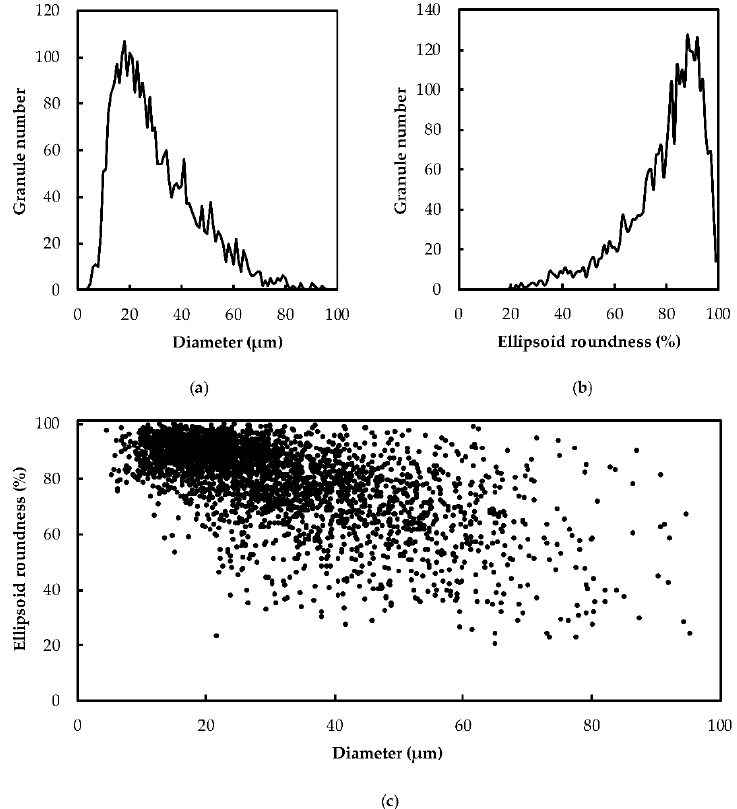
Figure 1. Size and shape analysis of unfractionated starch granules from potato cv. Monalisa. About 3000 starch granules were used for granulomorphometry. ( a ) Size distribution of potato starch. The number of analyzed granules was plotted versus their corresponding area diameter. ( b ) Shape distribution of Monalisa potato starch. Same as in (a) with the use of the ellipsoid roundness parameter. ( c ) Scatter plot of the ellipsoid roundness versus granule